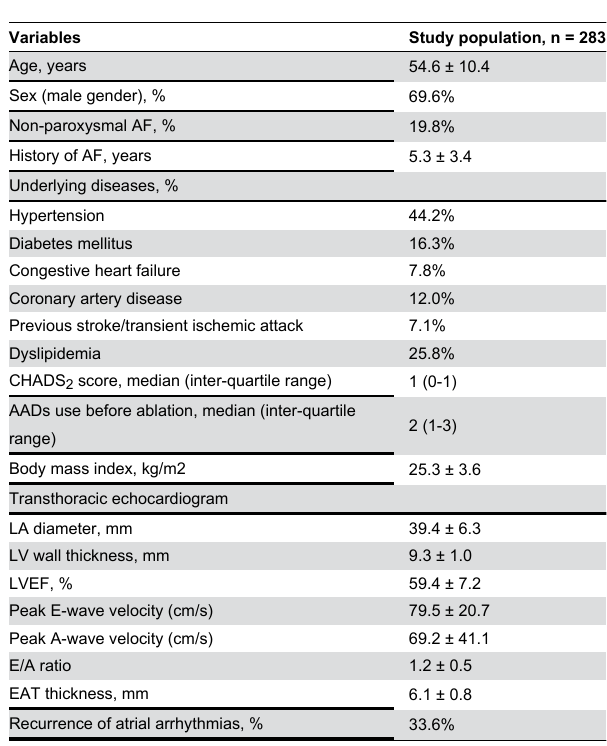
versus 14.1%, p value < 0.001) during the follow-up period (Figure 3B). curve (sensitivity = 71%; specificity = 64%), patients with thicker EAT had a higher recurrence rate after ablation procedures (71% versus 36%, p value = 0.008) (Figure 4B).